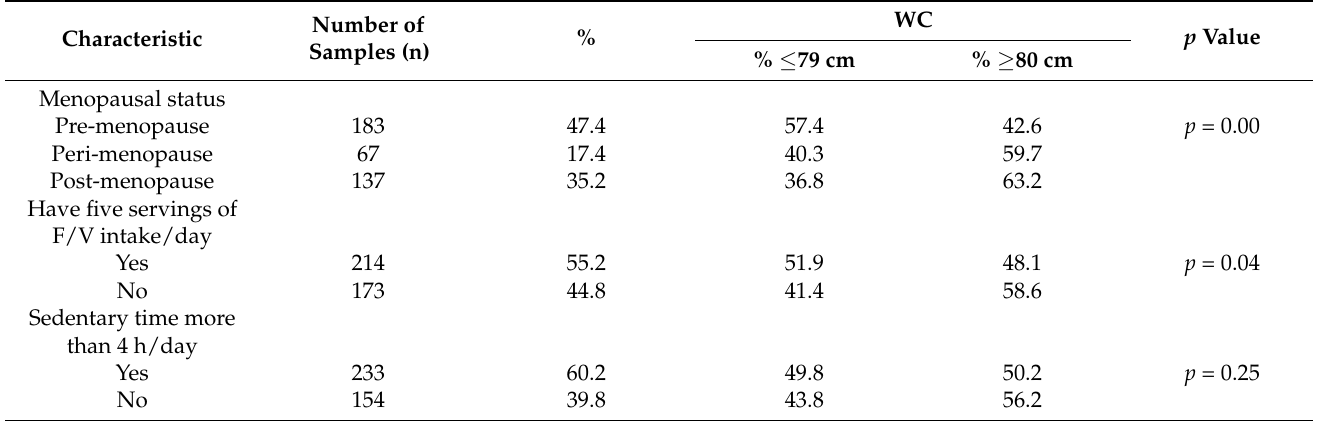
Table 2. Description of menopause status, F/V intake, and sedentary time of women with and without central